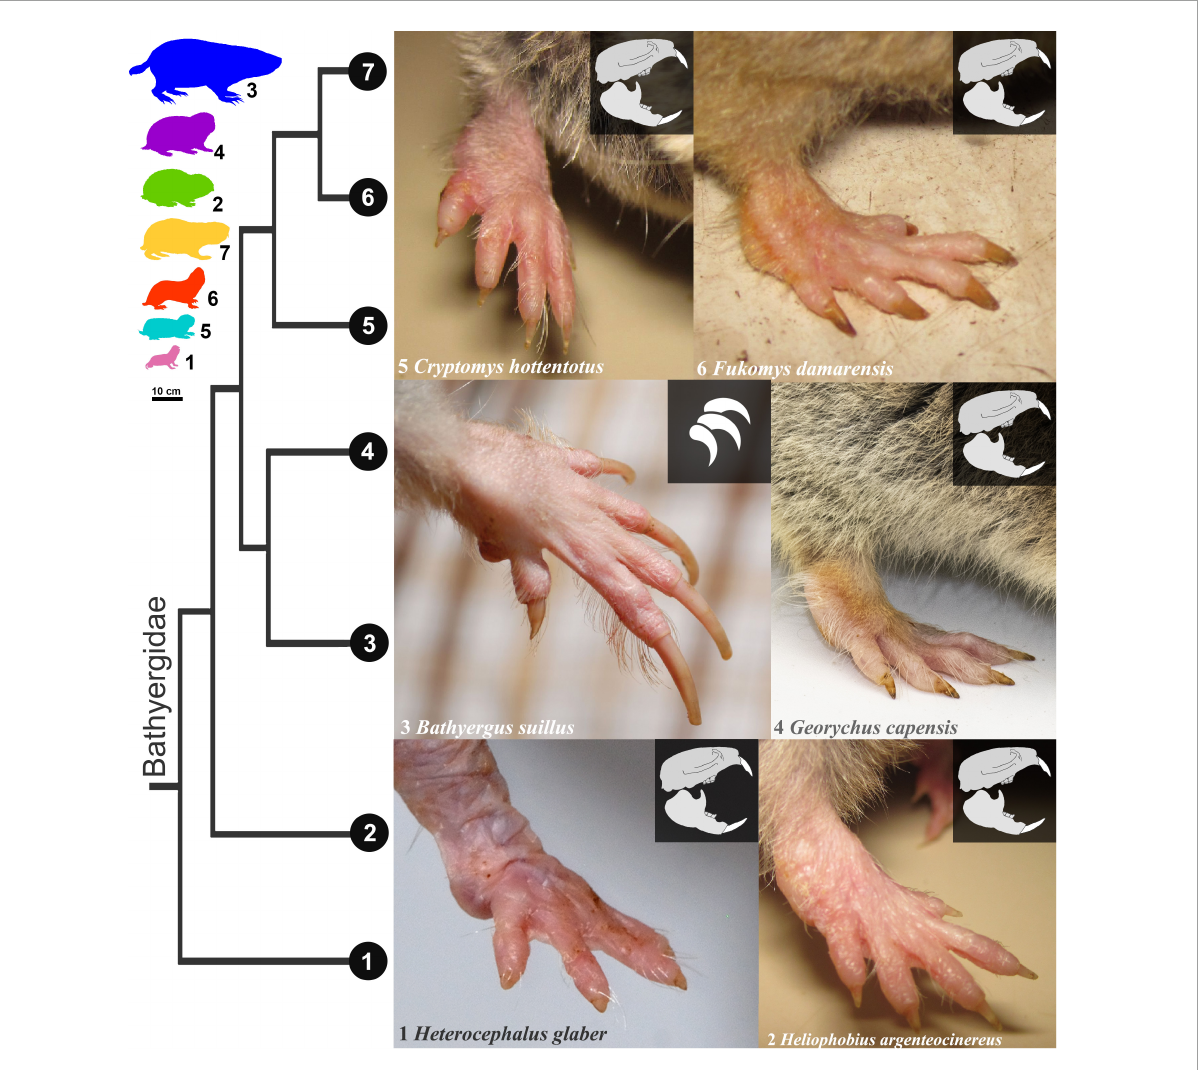
FIGURE1 Morphology of the manus of six African mole-rats species and a phylogeny of the Bathyergidae (based on Uhrová et al., 2022). Note the long claws of the scratch-digger Bathyergus suillus (claw symbol) and the reduced claw size of the rest of the chisel-tooth digger genera (skull symbol), particularly the poor development of claws in Heterocephalus glaber . Mole-rat silhouettes represent approximate body size differences between species. Fukomys mechowii (#7) is not portrayed in the figure, since exhibits similar claw morphology as other Fukomys species. Photography of species 1, 2, 3, 5, and 6 by Germán Montoya-Sanhueza© and species 4 by Maria